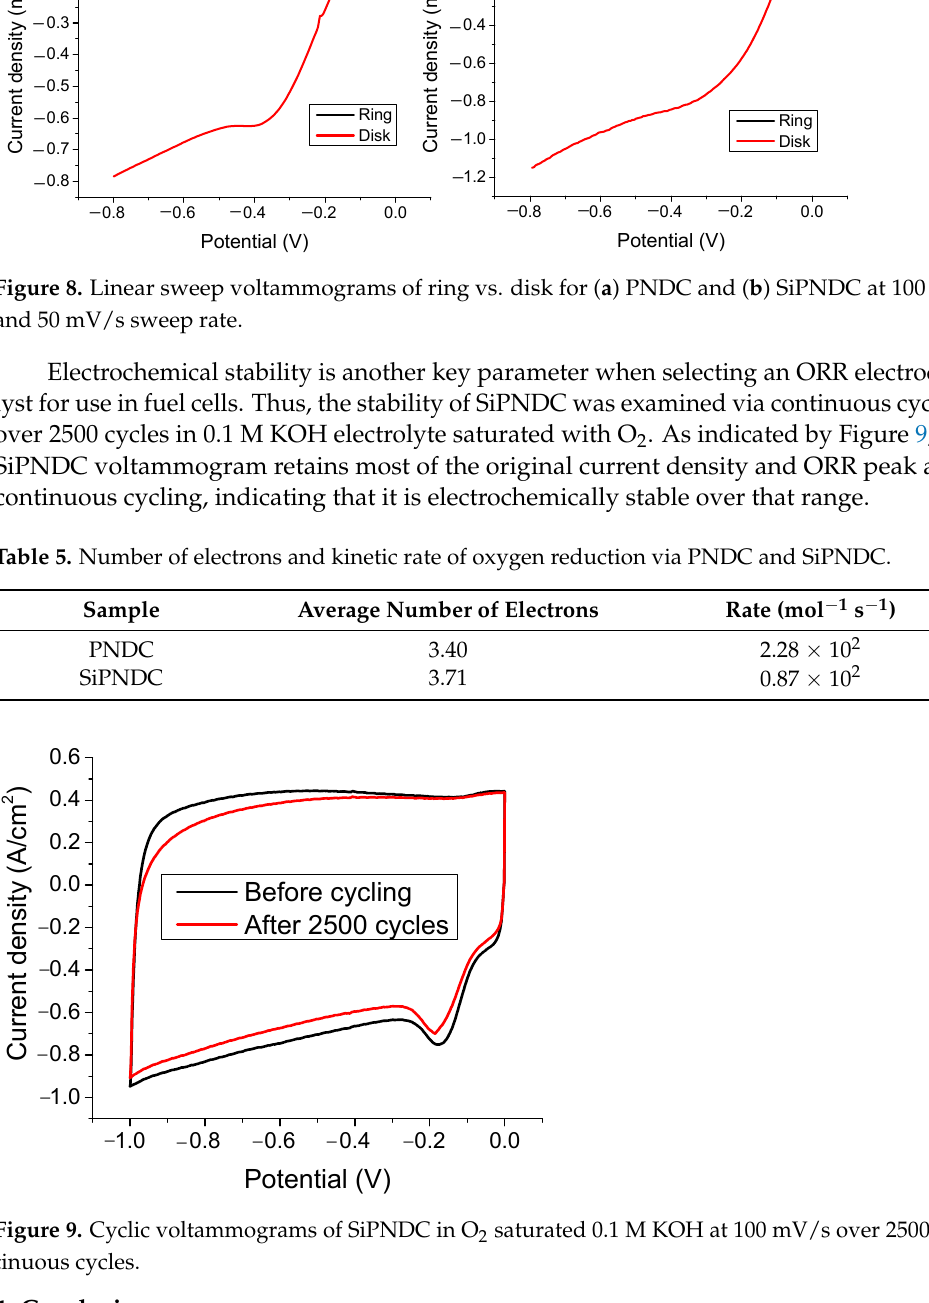
9 Figure 7. Koutecky–Levich plots and linear fit equations for PNDC, SiPNDC, and theoretical plots for 2-electron and 4-electron processes. Table 5 . Number of electrons and kinetic rate of oxygen reduction via PNDC and SiPNDC . Sample